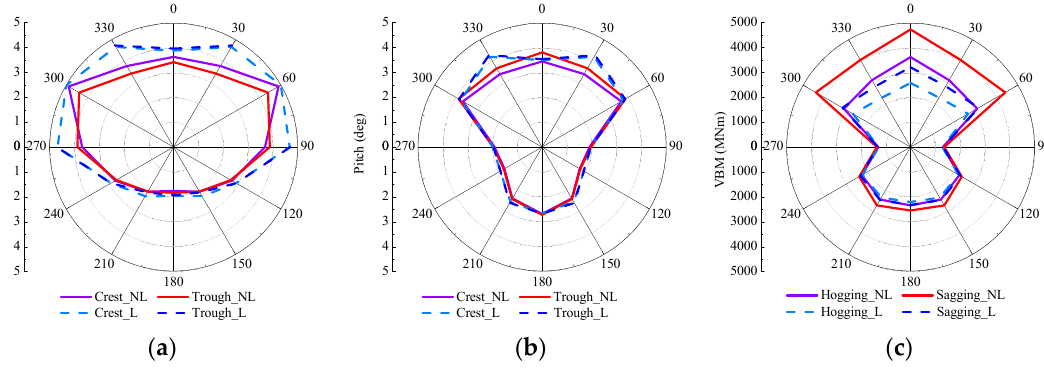
Figure 18. Comparison of short-term extreme values between linear and nonlinear schemes. ( a ) Heave; ( b ) pitch; ( c ) VBM.